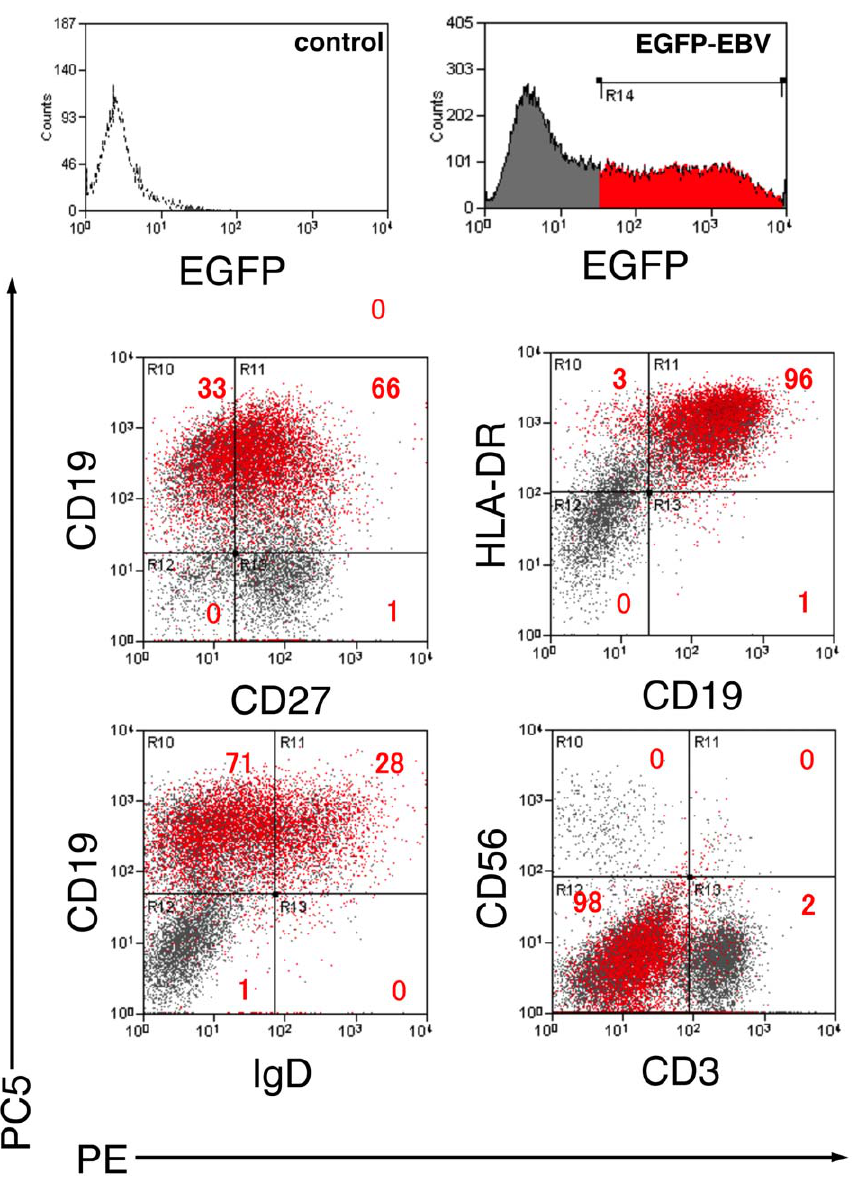
Figure 5. Phenotype of EGFP + cells in human tonsil tissue infected with EGFP-EBV using flow cytometry. Samples were obtained from EBV-infected tissues at 24 days post-infection. EGFP + (red) and EGFP 2 (grey) MNCs were gated and plotted on quadrants as PE-labeled and PC5- labeled surface antigens. A representative experiment is shown ( n =2). Numbers in quadrants indicate percentages of EGFP + lymphocytes for each surface